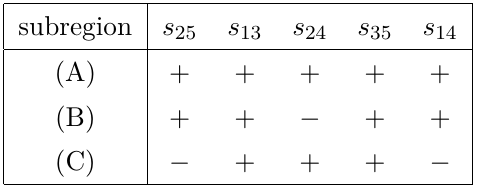
Table 1 . Subregions of the five-particle Euclidean region (3.6) which are specified by the signs of the nonadjacent bi-particle Mandelstam variables s . For subregions (B) and (C) there exist ii +2 four similar regions respectively that are obtained by cyclic